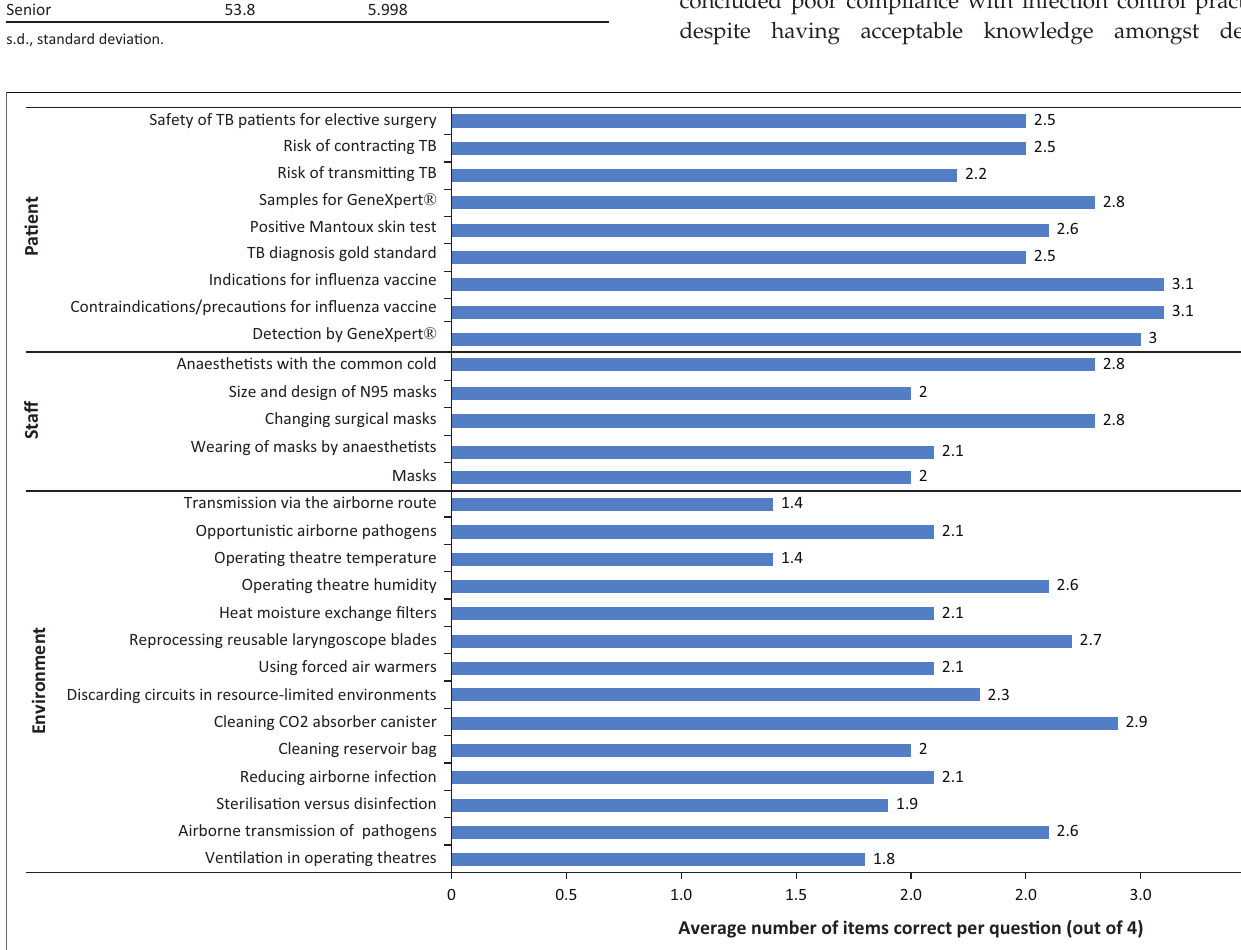
FIGURE 1: Number of items per question correctly